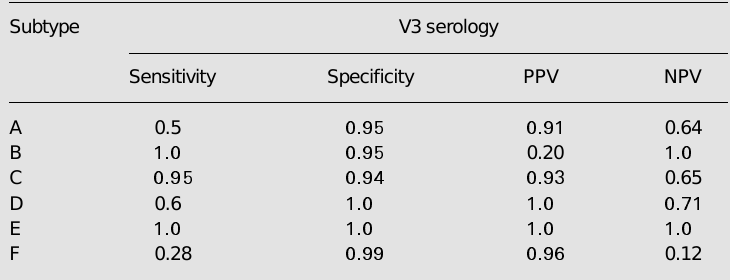
Table 3. Comparison of sensitivity, specificity and predictive values between V3 serology and